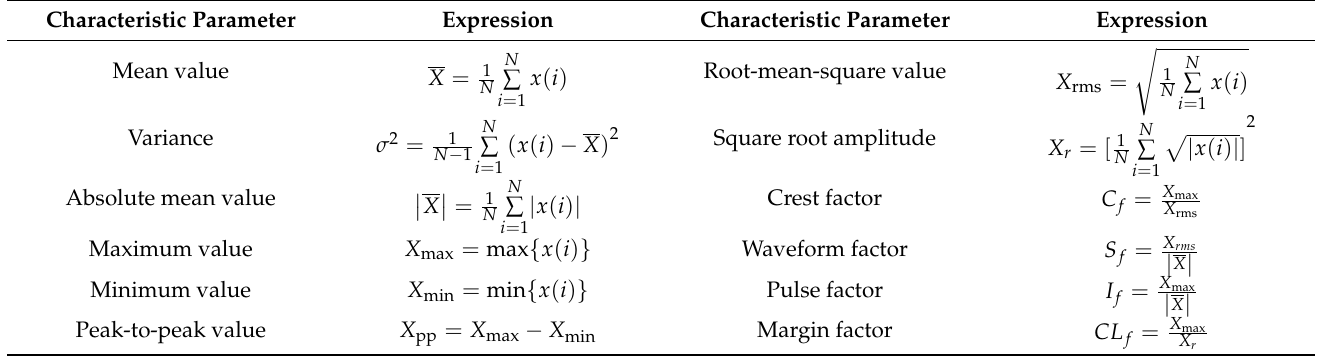
Table 2. The time-domain characteristic